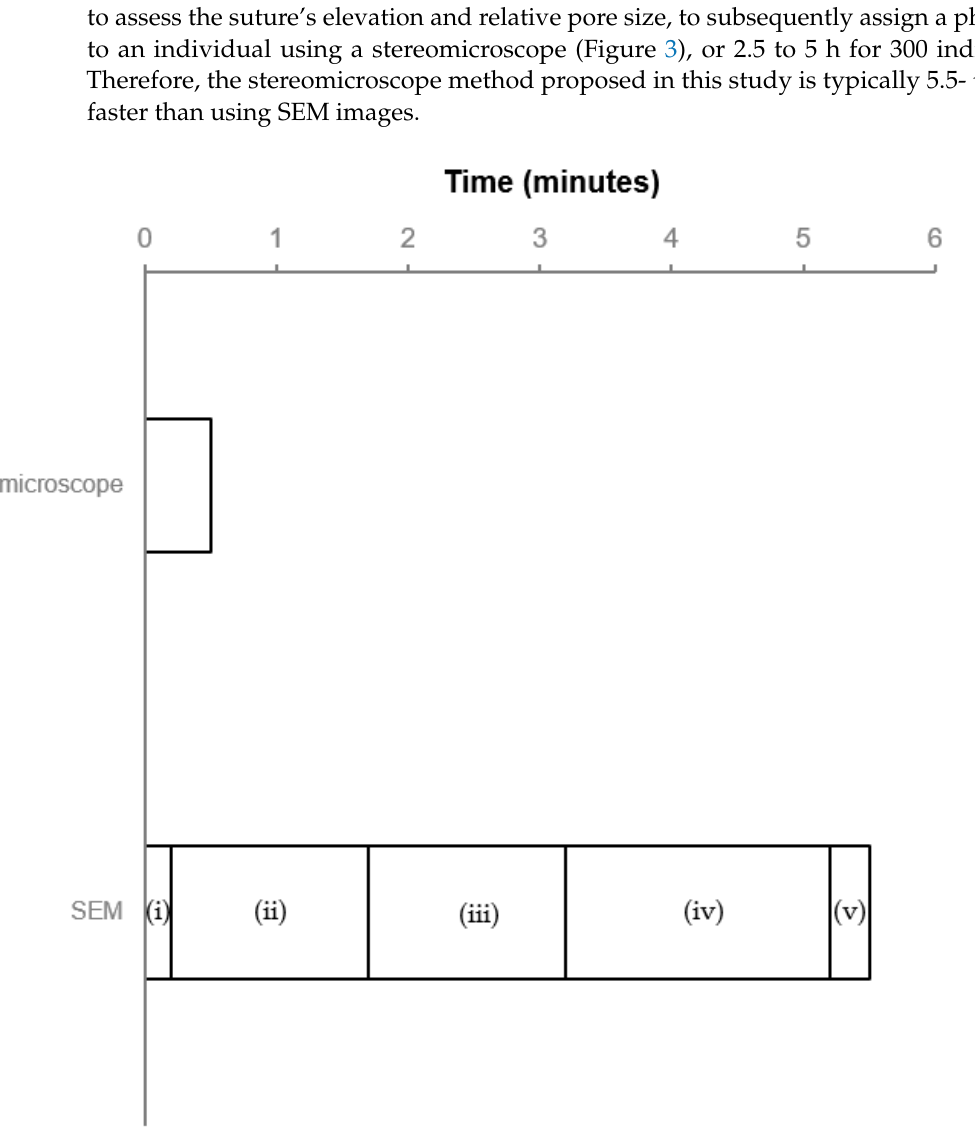
Figure 3. Overview of the time needed to identify the phylotype of a single Ammonia individual using SEM images and using a stereomicroscope. Numbers between brackets represent the different steps of the SEM method that are described in the text.